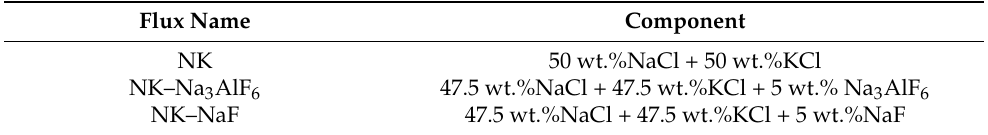
Table 1. The component of salt